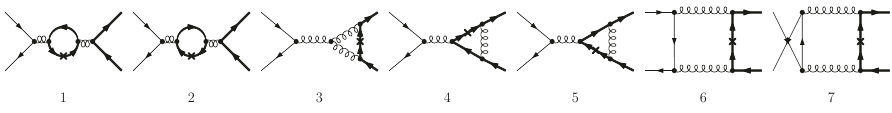
Figure 5 . Mass renormalisation counter-term